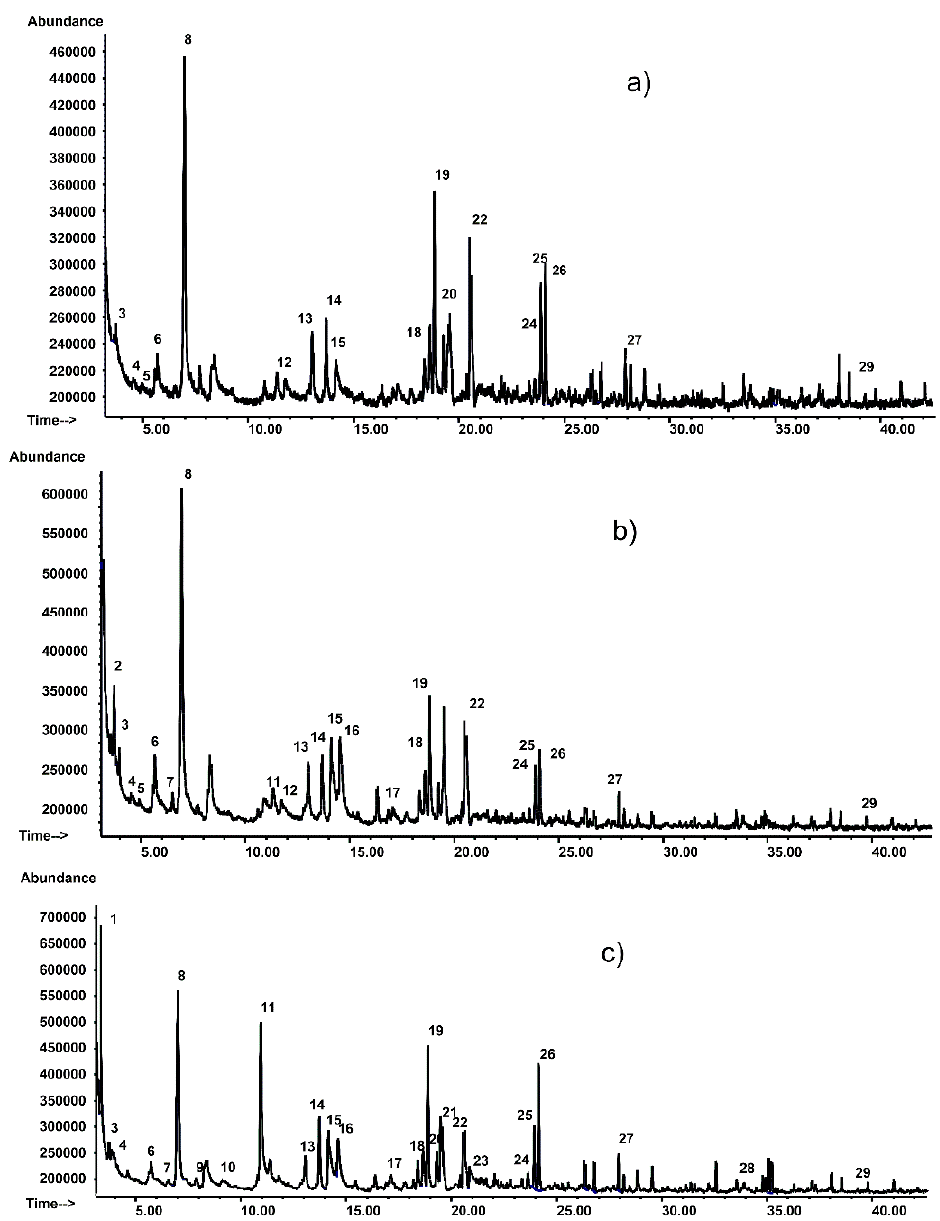
Figure 8. HS-SPME / GC–MS (EI) analysis of: ( a ) mu ffi n sample M_MUF; ( b )mu ffi n sample T_MUF; Figure 8. HS-SPME/GC–MS (EI) analysis of: ( a ) muffin sample M_MUF; ( b )muffin sample T_MUF; ( c ) mu ffi n sample C_MUF. M_MUF = Mu ffi n prepared by M_BP; T_MUF = Mu ffi n prepared by ( c ) muffin sample C_MUF. M_MUF = Muffin prepared by M_BP; T_MUF = Muffin prepared by T_BP; C_MUF = Muffin prepared by C_BP. Numbers 1-29 indicate the identified compounds reported in